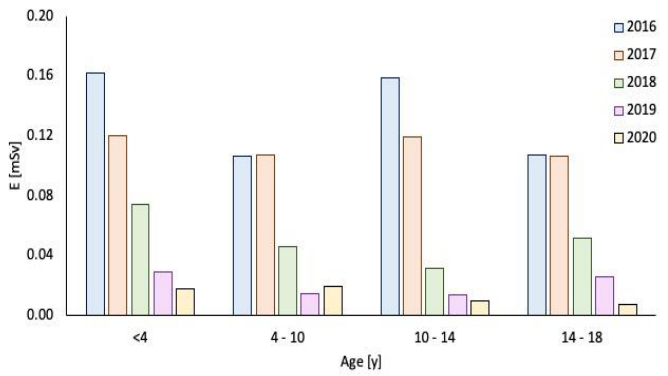
Figure 3. Total radiation dose (mSv) in different patient age groups.